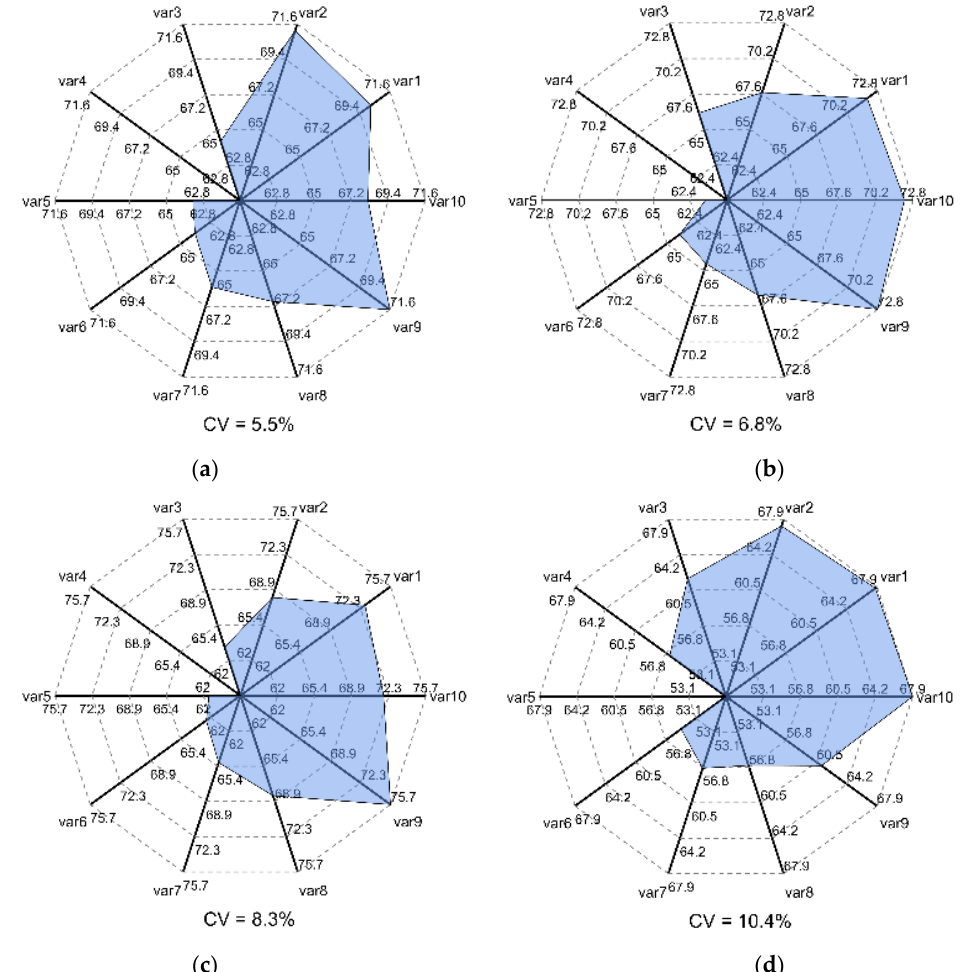
Figure 10. Displacement and variation coefficient of each outlet corresponding to different inlet air velocities. ( a ) Inlet air velocity is 25 m/s; ( b ) Inlet air velocity = 30 m/s; ( c ) Inlet air velocity = 35 m/s; ( d ) Inlet air velocity = 40 m/s.